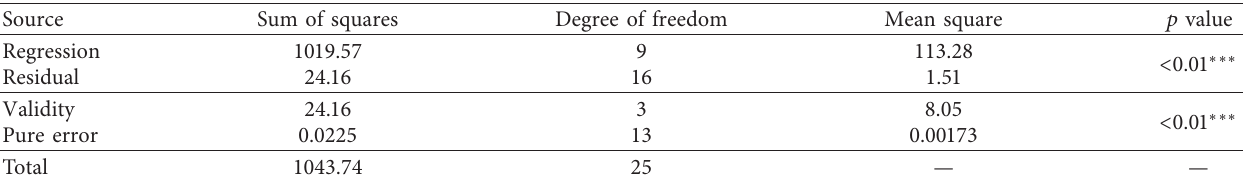
Table 3: Analysis of variance (ANOVA) for the second-order model correlating the content of phenolic compounds with the experimental variables.